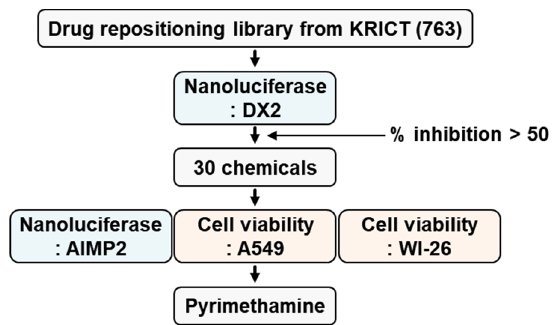
Figure 1. Screening to identify DX2 inhibitors. 763 chemicals (5 µM) from KCB at KRICT was used for